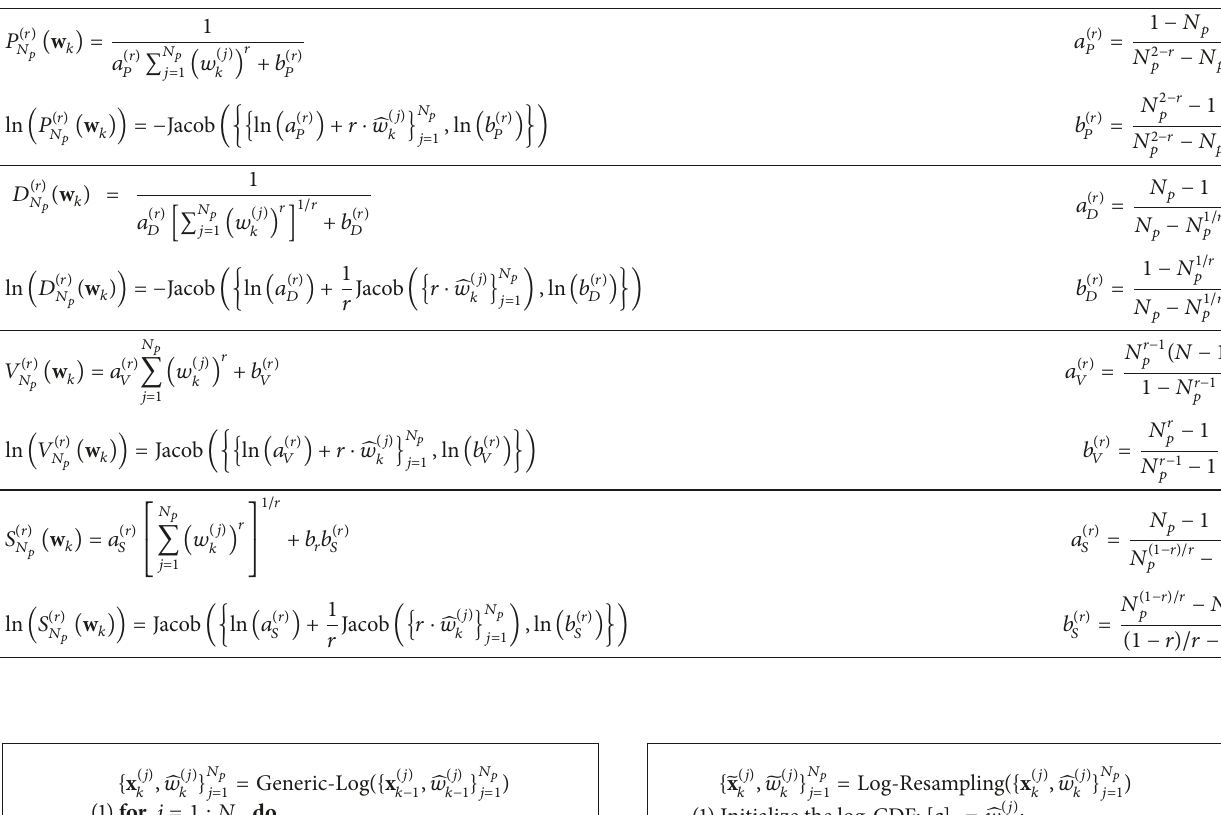
( w ),𝐷 (𝑟) ( w ),𝑉 (𝑟) ( w ), 𝑆 (𝑟) ( w ) to approximate 𝑁 𝑘 𝑘 𝑘 𝑘 𝑁 𝑝 𝑁 𝑝 𝑁 𝑝 𝑝 ( w ) as in (15) is obtained from 𝑃 (𝑟) 𝑘 𝑝